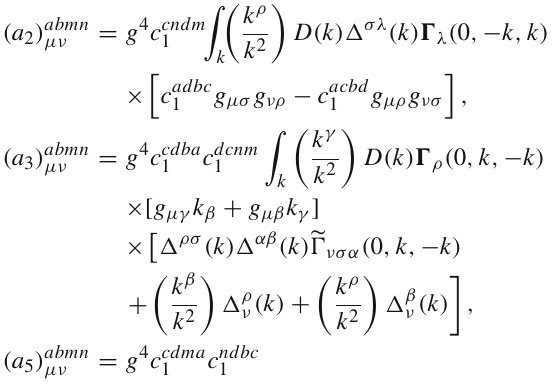
Fig. 4 First row: The skeleton expansion of the five-particle ker- nel K abcem is shown as the sum of the 1PR and 1PI contribu- 5 μνρ tions, denoted by T abcem and G abcem , respectively; the dots indi- 5 μνρ 5 μνρ